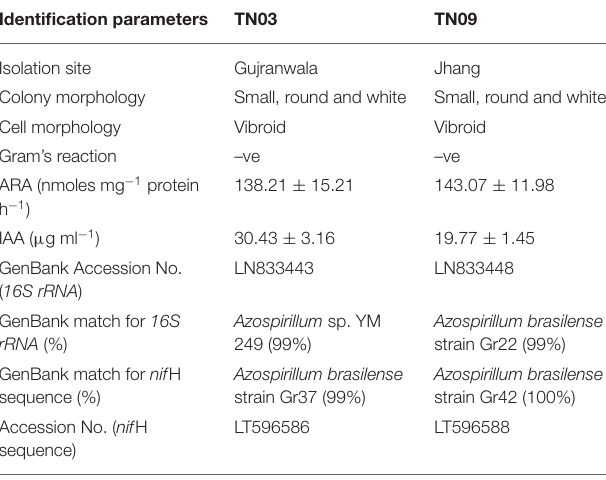
TABLE 2 | Morphological, biochemical and molecular identification of TN03 and TN09 strains purified from potato rhizosphere. Identification